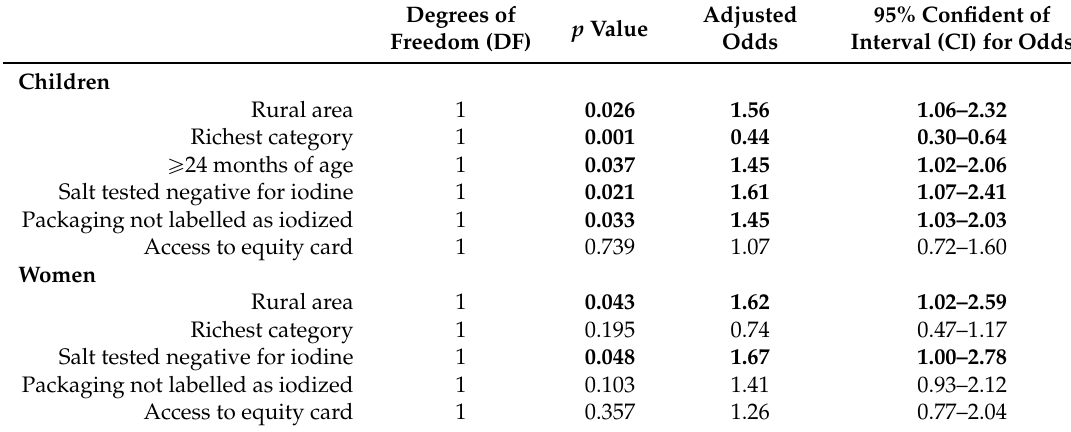
Table 5. Multivariate model analysis: binary logistic regression analysis for the risk factors associated with UIC below 100 µ g/L (Variables in the model were selected through a backward stepwise conditional approach. Variables not significant in the model ( p > 0.05) were excluded. The covariates used to build the model were: age for children only (<24 months, above or equal to 24 months); salt test at household (positive for iodine and not positive for iodine), access to equity card (yes and no), and packaging of salt at household (labelled as iodized and no labelling), living area (urban/rural), and wealth quintile (poor and rich). Results were considered significant at p <